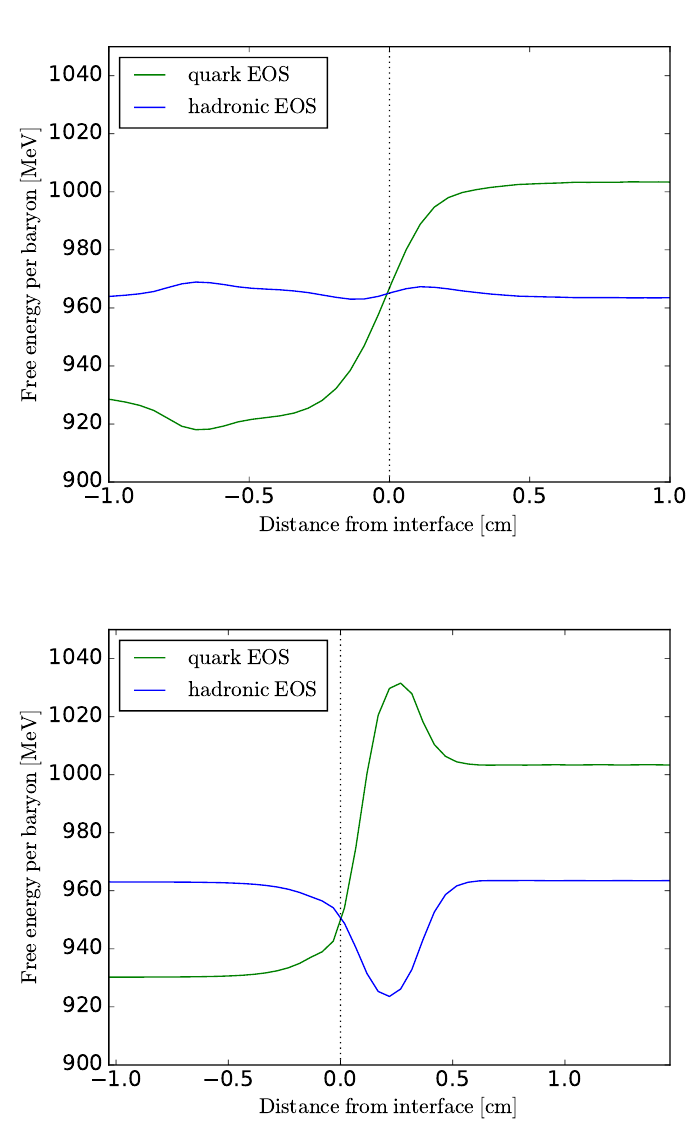
Figure 2. Helmholtz free energy per baryon versus distance from interface. Upper panel ( a ): The interface with neutrino absorption turned off. The initial hadronic density was n B = 0.2 fm − 3 . We can clearly see that the free energies of quark matter is lower in the left side of the interface than hadronic matter. This implies that a quark matter ash exists in the left side since it is energetically favorable; Lower panel ( b ): The interface with the neutrino absorption turned on. we can clearly see a free energy barrier forming, with the free energies of quark matter and hadronic matter diverging in the right side of the interface. Subfigure (b) was taken from Ouyed’s PhD thesis